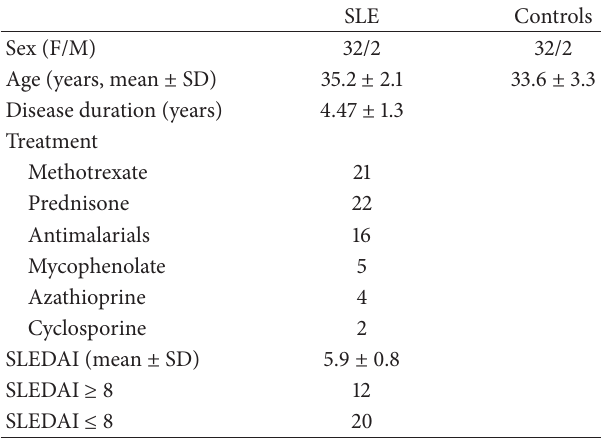
Table 1: Clinical characteristics of systemic lupus erythematosus (SLE)